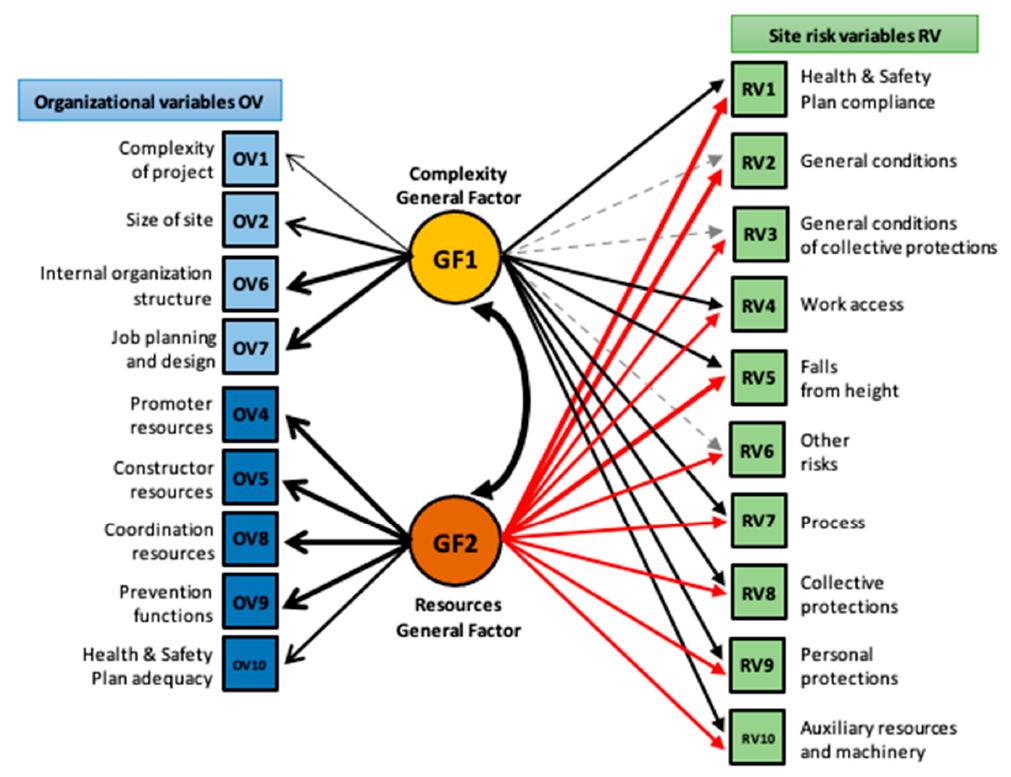
Figure 1. SEM model connections between risk and organizational variables. Modified from Forteza et al. [25].